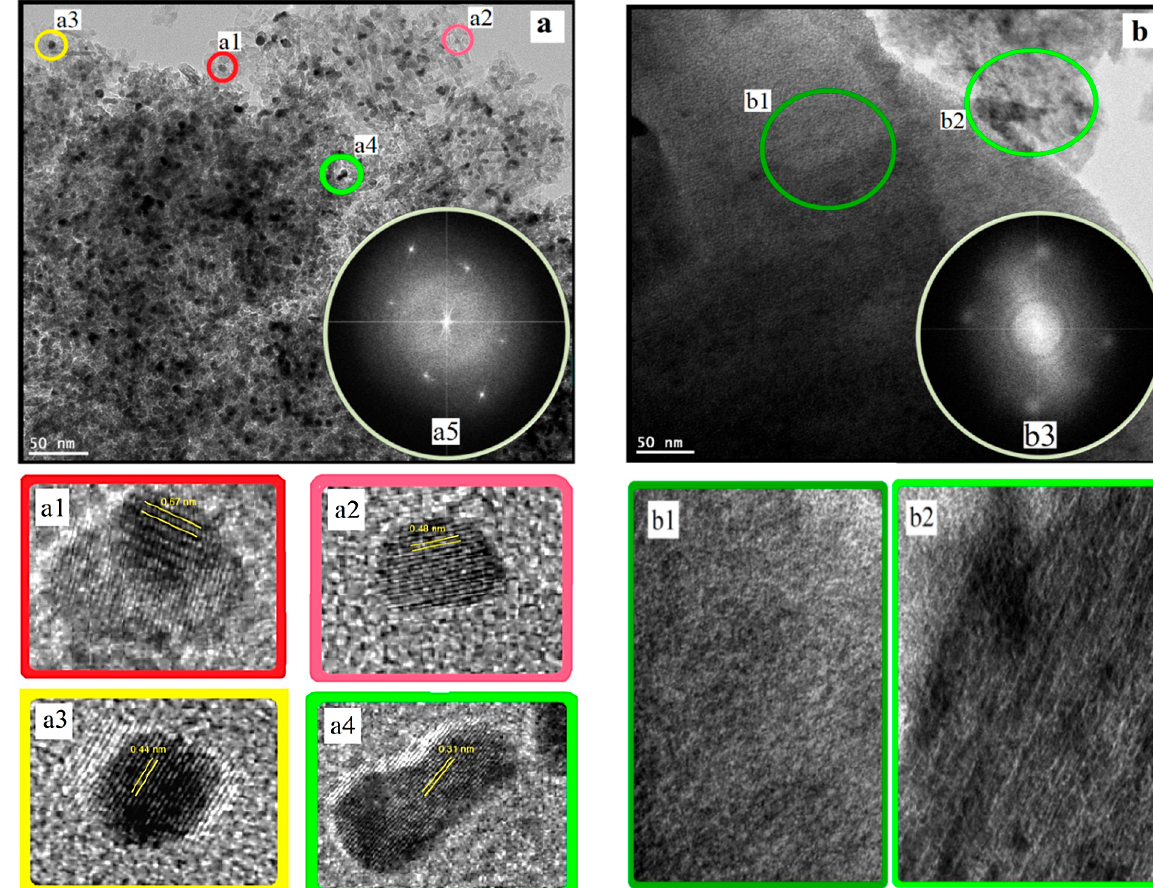
Figure 3. The TEM images of the Mn/Al ( a ) and Mn-BTC arg /Al ( b ), HRTEM images of the Mn/Al ( a1 – a4 ) and Mn-BTC arg /Al ( b1 , b2 ) and FTT analysis of the Mn/Al ( a5 ) and Mn-BTC arg /Al ( b3 ) samples.